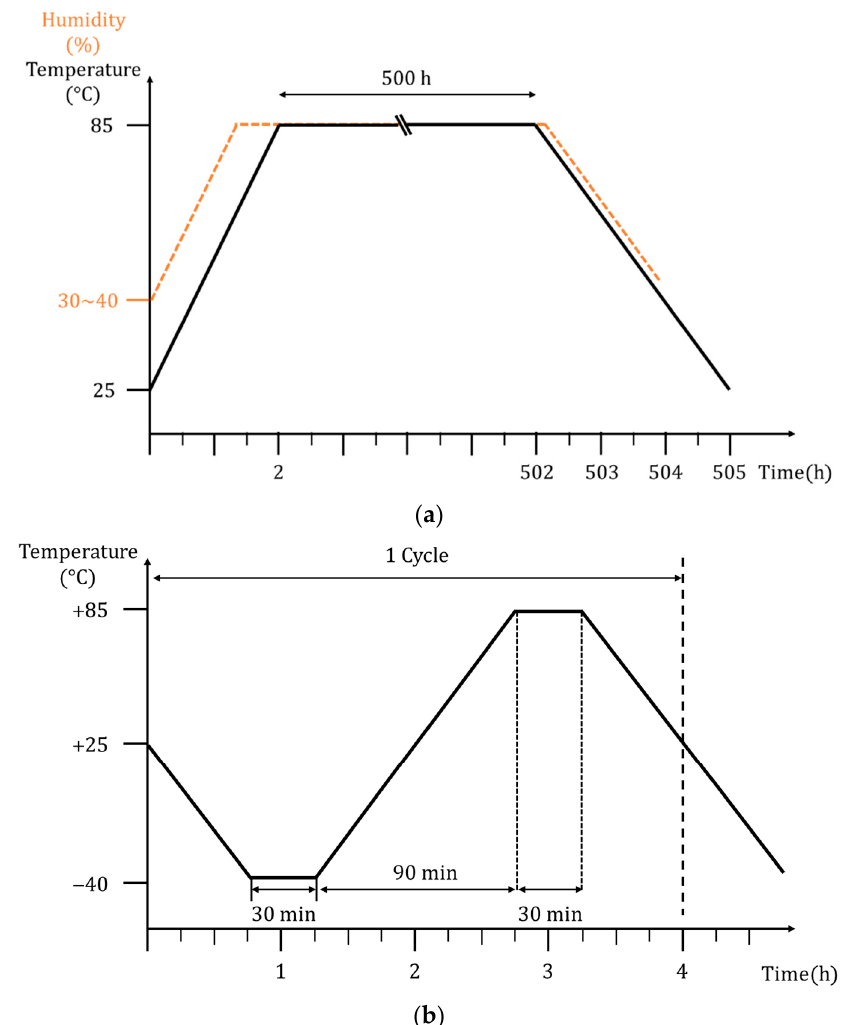
Figure 1. ( a ) Time–temperature and humidity profile for DH500 test and ( b ) time–temperature profile for TC test.